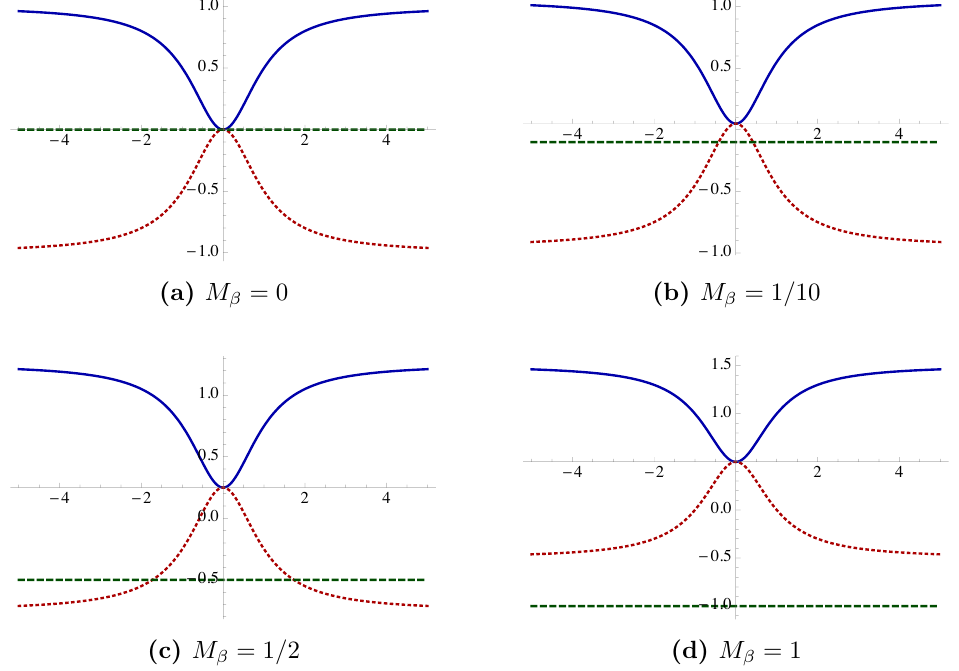
Figure 6. Brane embeddings of the form (4.8) for di(cid:11)erent values of M (cid:12) . In all the plots we have (cid:12)xed M (cid:11) =